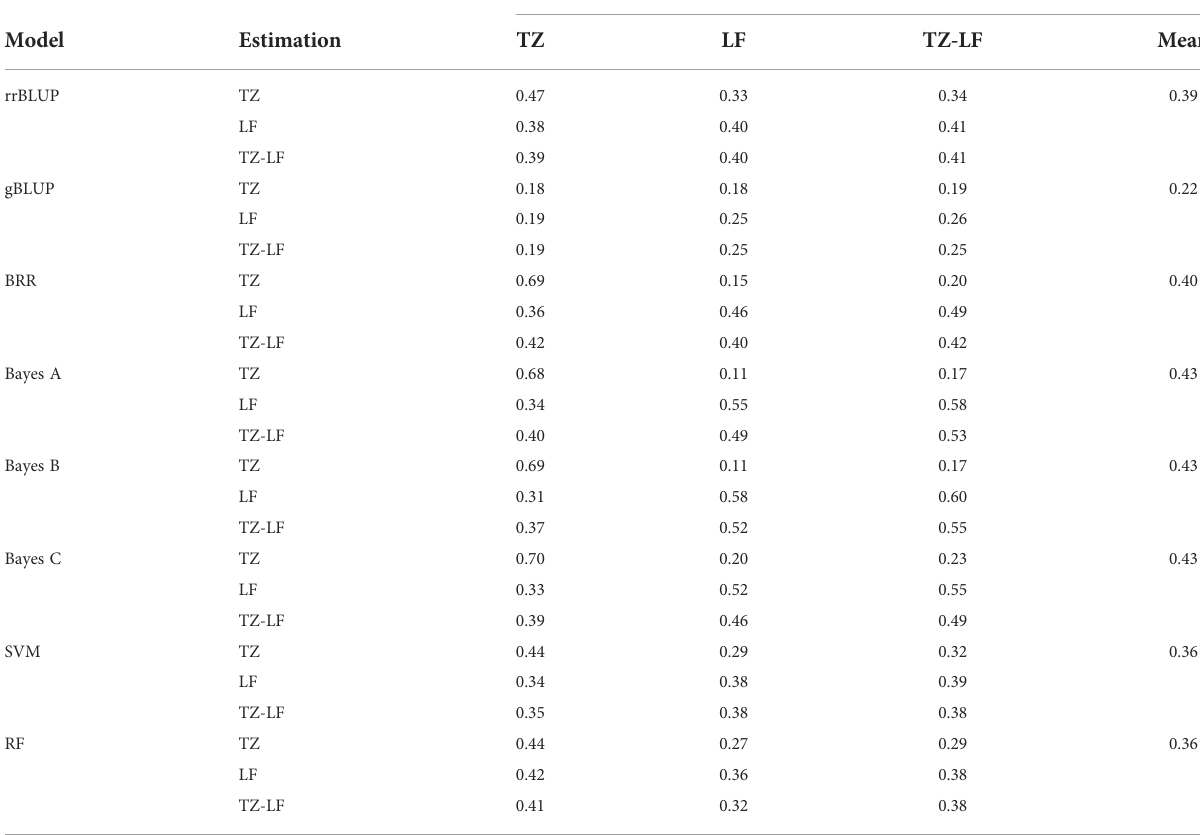
TABLE 3 The genomic prediction accuracy of total biomass yield in the P149 population validated within and across